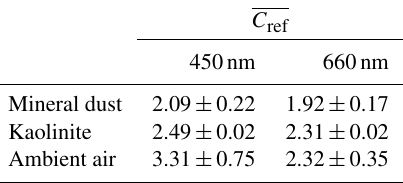
Table 3. Mean and standard deviation multiple scattering correc- tion C ref at 450 and 660nm for dust, kaolinite, and ambient air. The C ref was calculated as the mean of the C ∗ , C ref (W2003), and ref C ref (C2010) obtained at each wavelength for the different aerosol types. As a reminder, C ∗ is the multiple scattering correction ob- ref tained when not taking into account the loading effect correction in Aethalometer data; C ref (W2003) and C ref (C2010) take the load- ing effect correction into account by using the parameterizations by Weingartner et al. (2003) and Collaud Coen et al. (2010), respec-